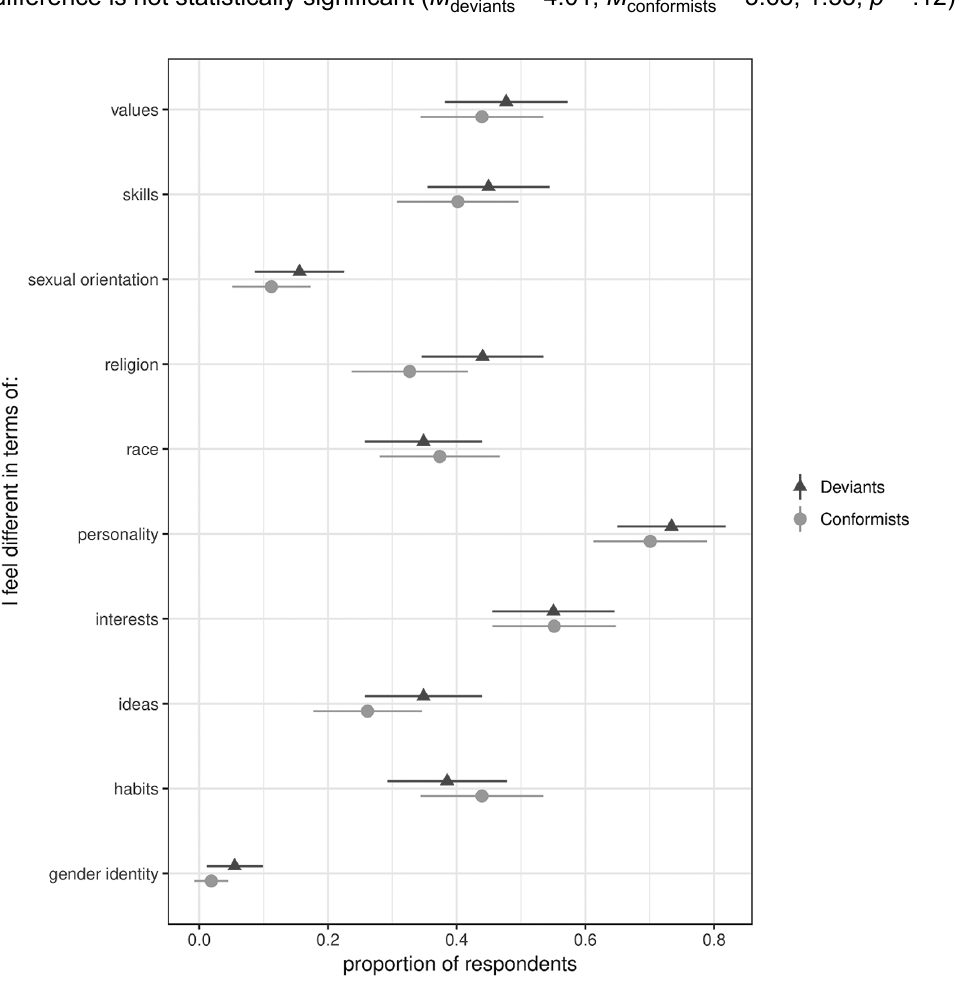
Figure 3. Proportion of deviants and conformists who reported that the items displayed on the y-axis (e.g., personality, values, race, etc.) have made them feel different from other members of their social groups, and 95% confidence interval